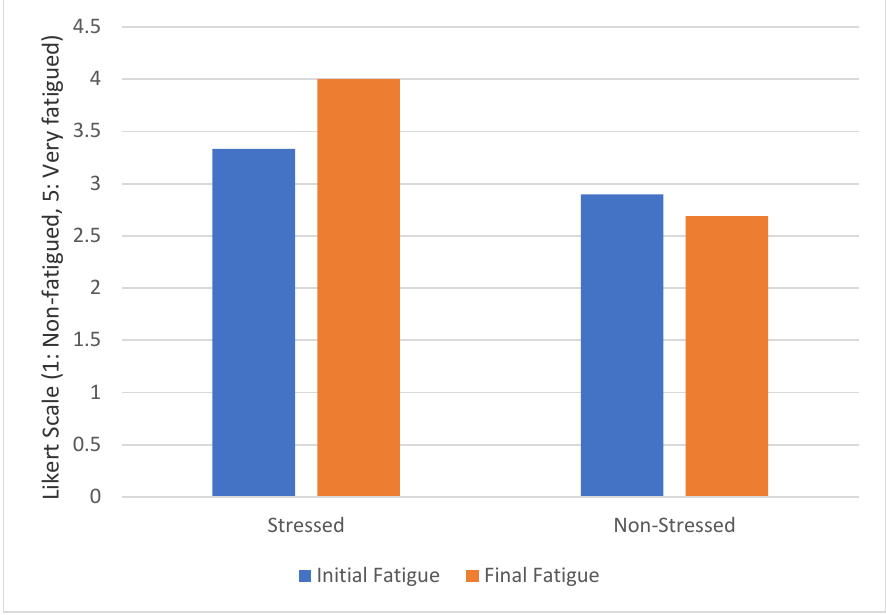
Figure 3. Fatigue evolution grouped by initial stress level.